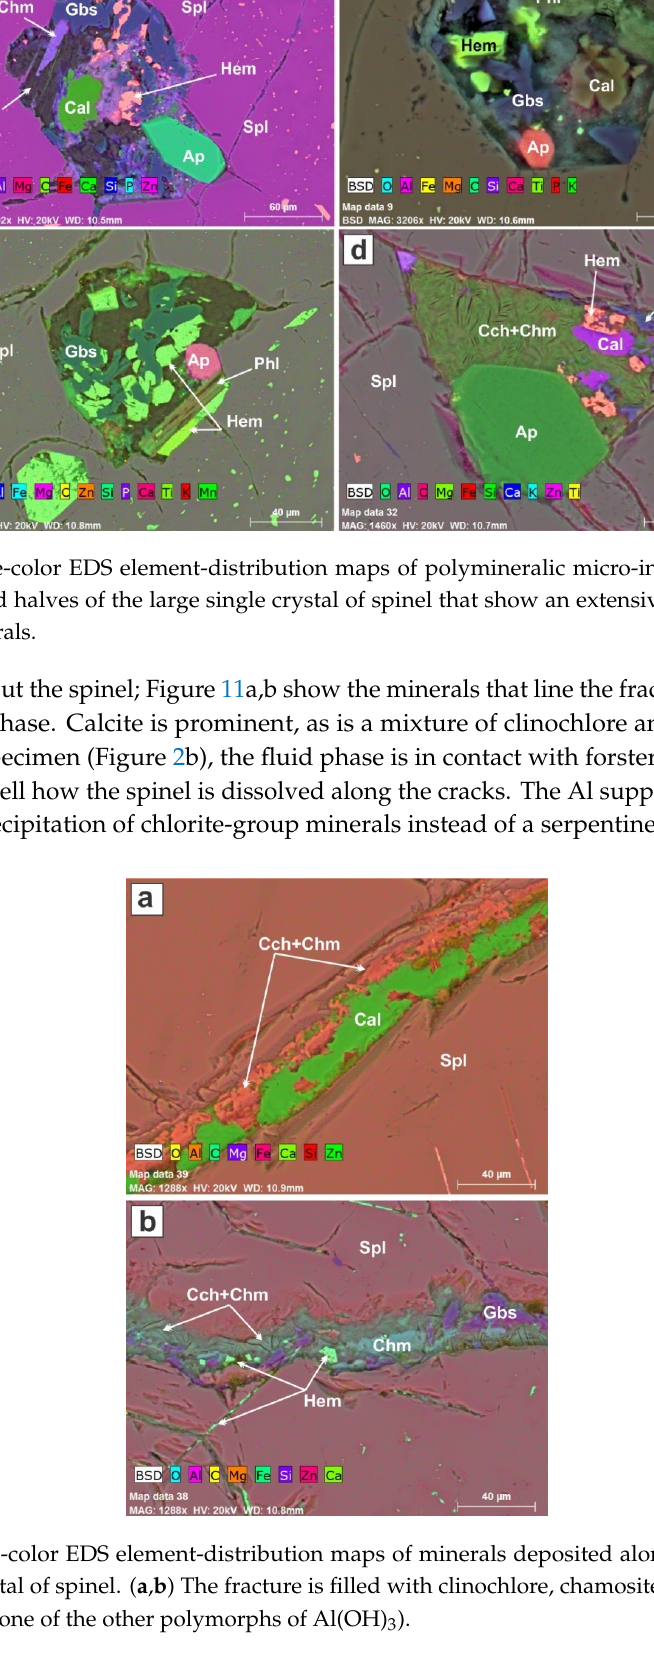
Figure 11. False-color EDS element-distribution maps of minerals deposited along fractures in the large single crystal of spinel. ( a , b ) The fracture is filled with clinochlore, chamosite, calcite, hematite, and gibbsite (or one of the other polymorphs of Al(OH) 3 ).